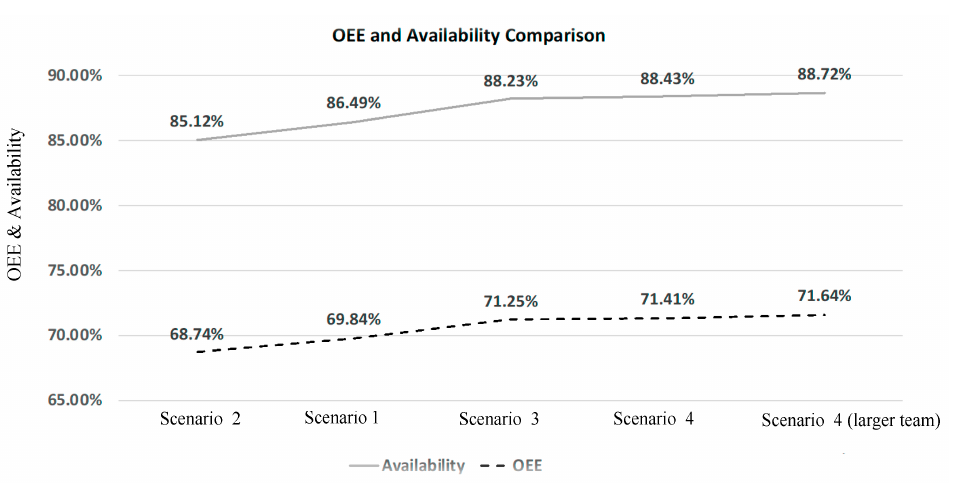
Figure 4. OEE and availability comparison among simulations.